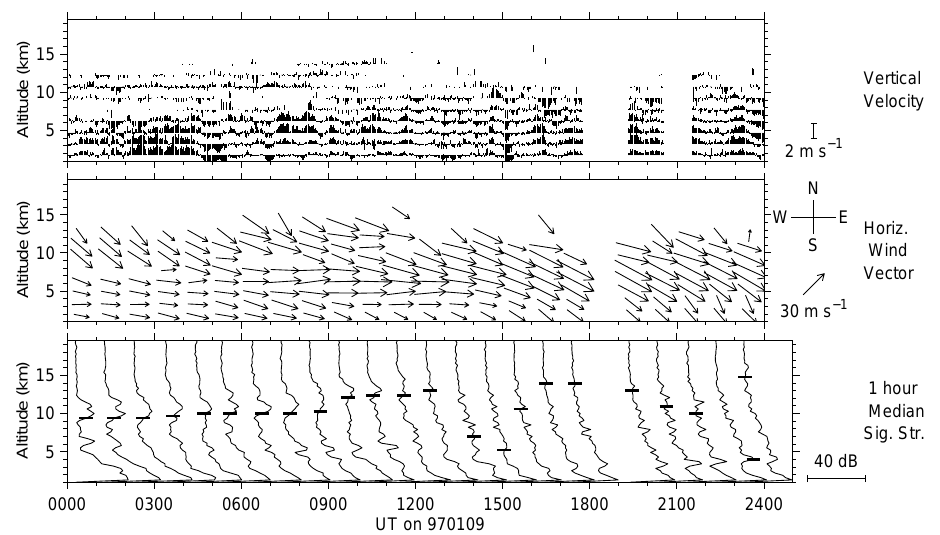
Fig. 5. ESRAD MST radar signal strengths with retrieved tropopause heights marked, horizontal and vertical winds on 9 January 1997.